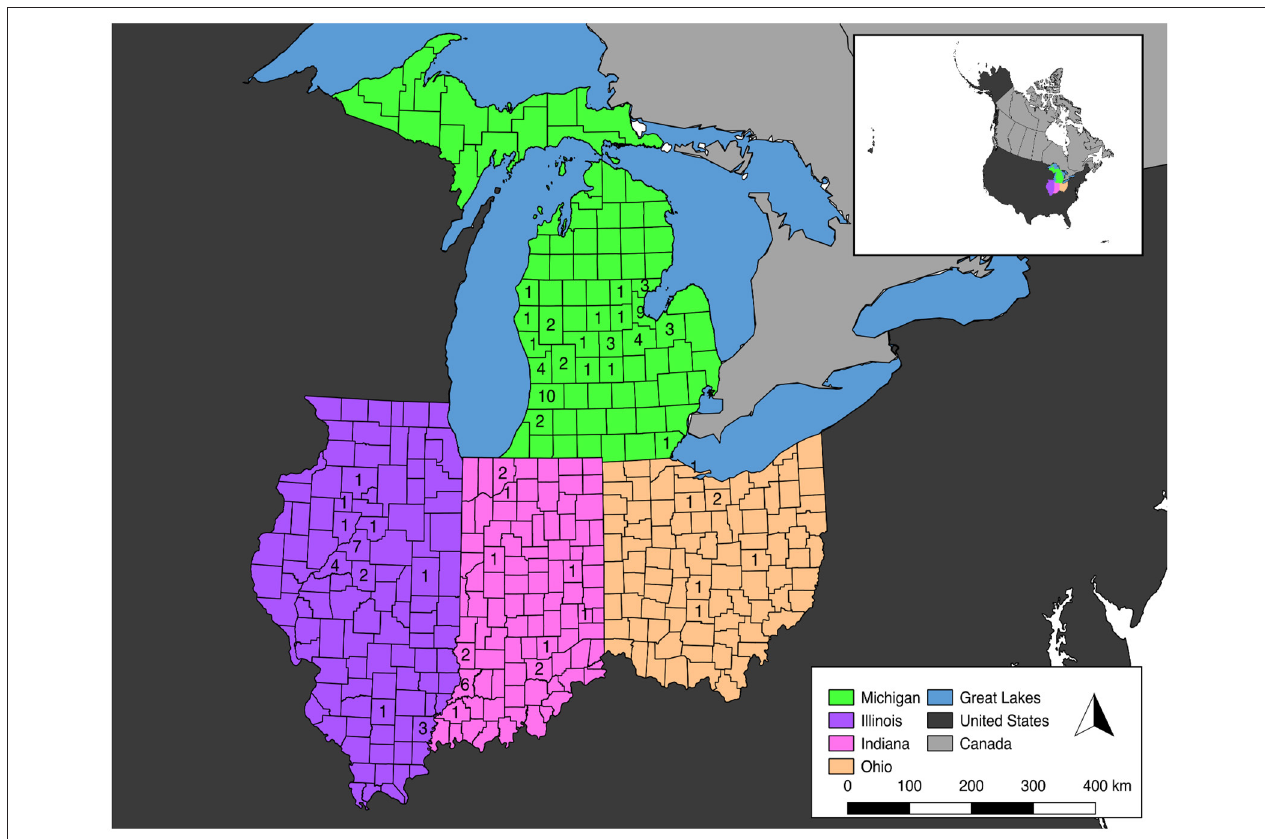
FIGURE 1 | Map of study region showing distribution of surveys across the Midwest, USA. Farmers from 47 counties responded to our survey. Numbers on counties represent the total number of surveys from the given